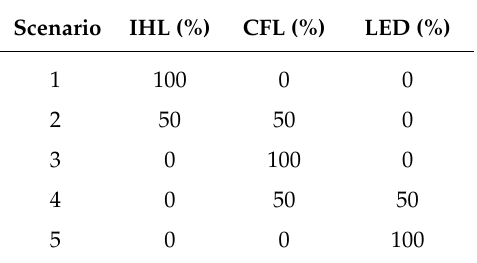
Table 3. Percentage of lamps per scenario.